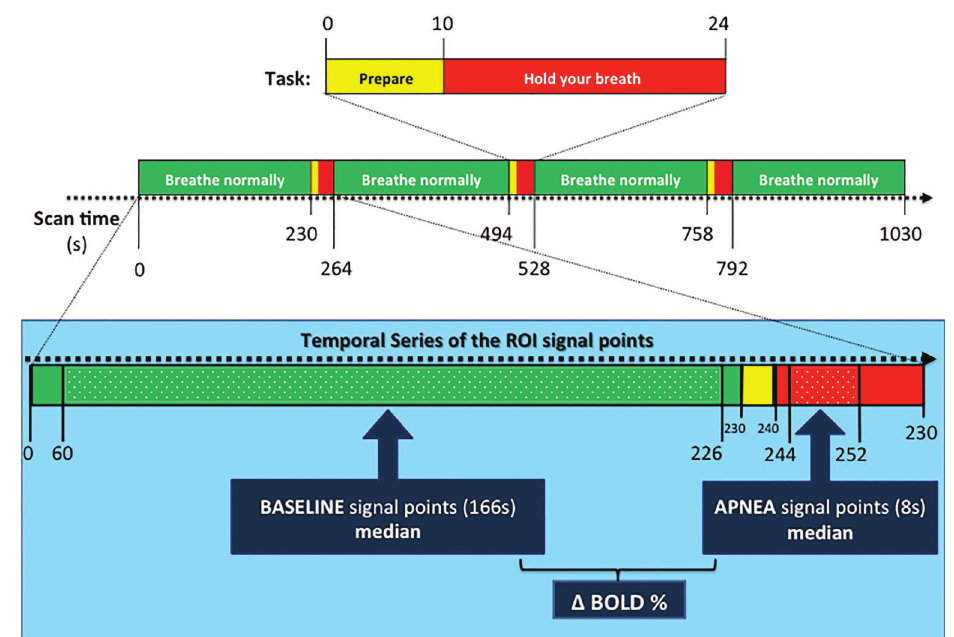
Figure 1. Top : visual BOLD-functional MRI activation paradigm based on traf fi c lights for instructing subjects on breathing tasks during echo-planar image acquisition. Bottom , within the light blue rectangle: a detailed view of the temporal series of the region of interest (ROI) signal points that were considered for baseline and apnea signal points median calculation, as well as the for the percent variation in the magnitude of stimulus-induced BOLD signal (delta